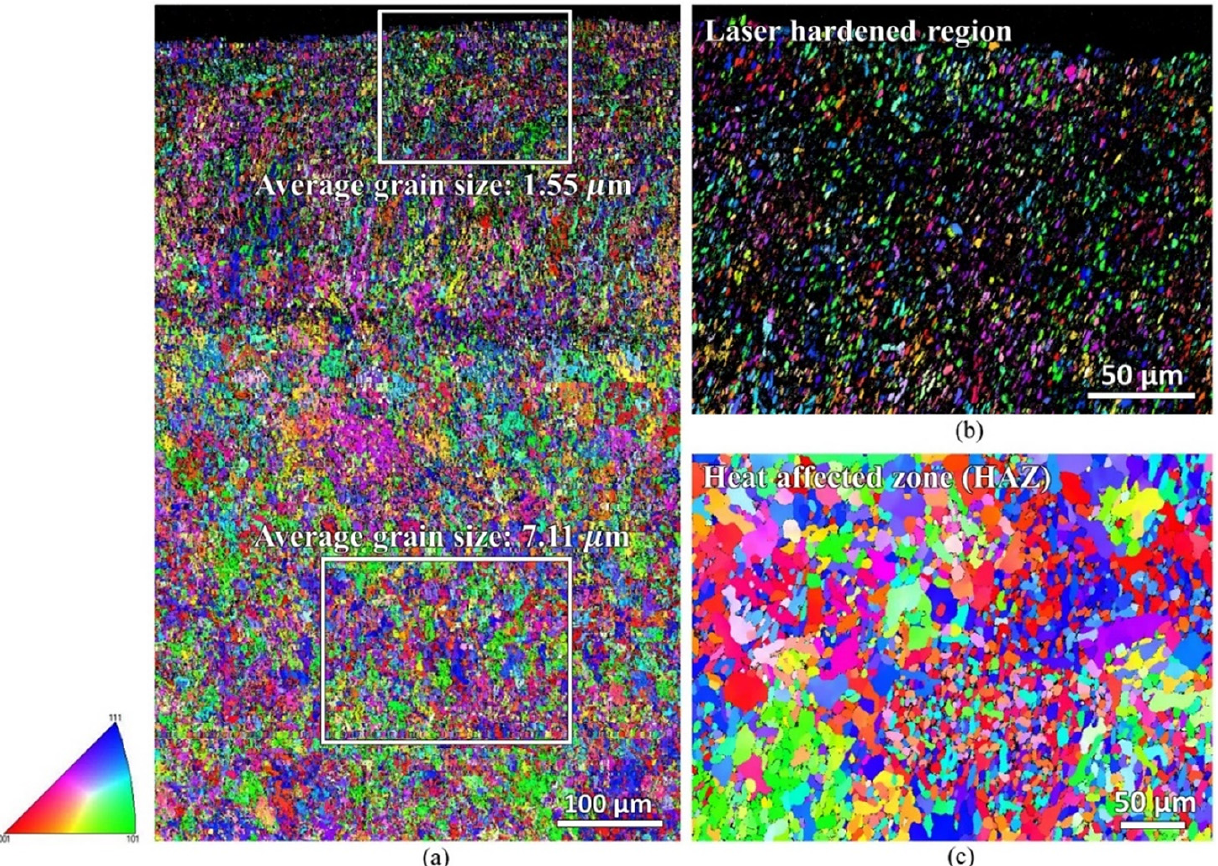
Figure 7. EBSD IPF-Y map showing different grain orientations and size of the laser-hardened sample: ( a ) low magnification; ( b , c ) high magnification of laser-hardened and heat affected zone (HAZ) regions.